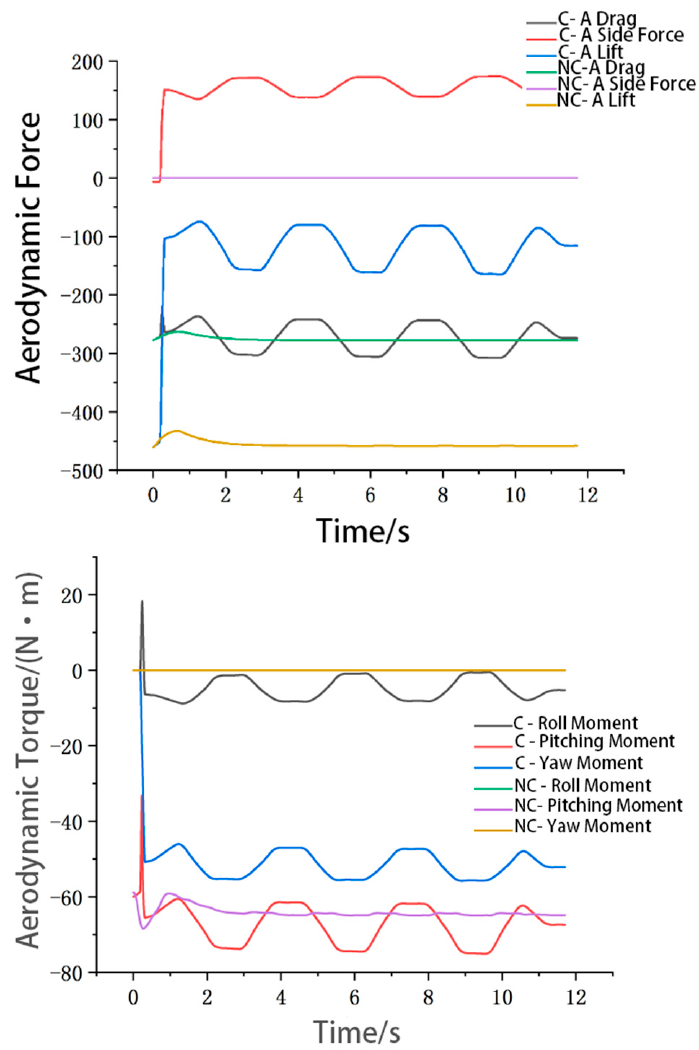
Figure 15. Comparison curves of aerodynamic force and aerodynamic torque with and without crosswind over time: C—A is the crosswind-aerodynamic, NC—A is the no crosswind aerodynamic, C is the crosswind and NC is the no crosswind.